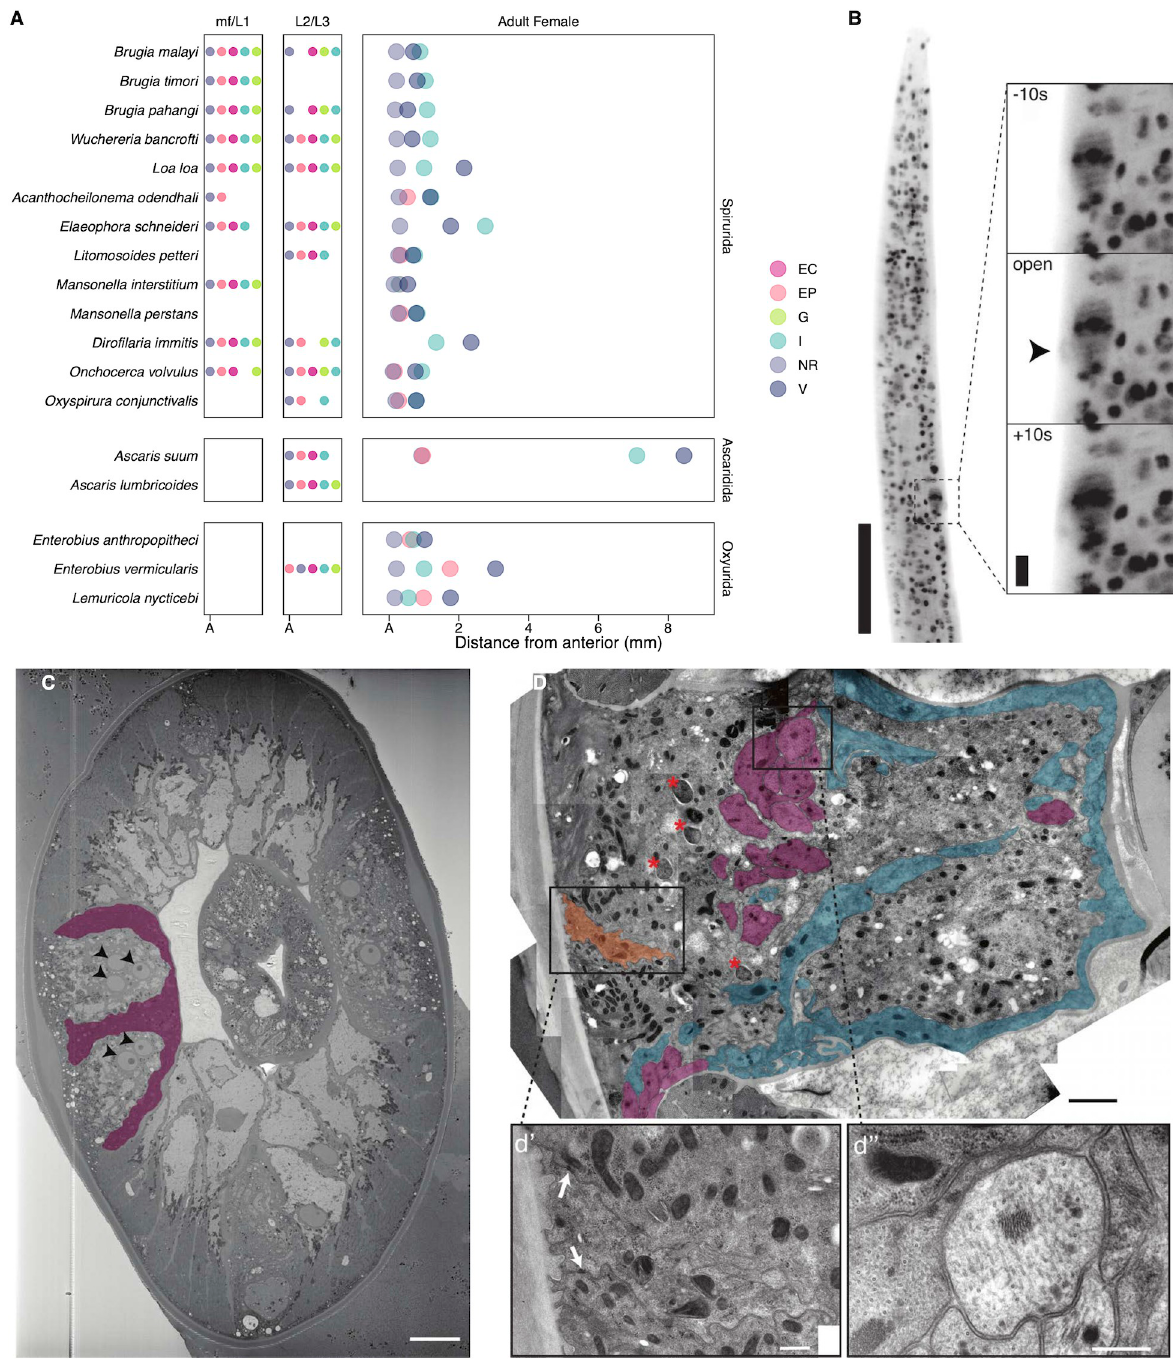
Fig 2. Coordinating the elusive excretory-secretory system in the adult B . malayi head region. (A) Comparative anatomy of Clade III nematode head structures from published descriptions (detailed in S1 File ). Positions of the nerve ring = NR, excretory-secretory pore and/or vesicle = EP, excretory cell = EC, genital primordium of larvae = G (larvae), vulva = V, and esophageal-intestinal junction = I shown as rank order for larvae and average micron distances from anterior in adult stages (A = anterior). (B) Light sheet maximum intensity projection of ES pore pulsing activity (arrowhead) in DRAQ5 stained live adult male B . malayi . Scale bars = 100 μ m and 10 μ m for insets. (C) Single section from adult female SBF-SEM showing multinucleated (arrowheads) epidermis within the lateral cord and membranous structures (pseudocolor purple) that are embedded within and surround the lateral cord (structures highlighted for one of two lateral cords). Scale bar = 10 μ m. (D) TEM of lateral cord in adult male showing likely seam cell homolog (pseudocolor orange), membranous processes enriched in microtubules (pseudocolor purple), membranous processes lacking obvious microtubules (pseudocolor blue), and Wolbachia endosymbionts (asterisks). (d’) Closeup of seam cell, identifiable by the